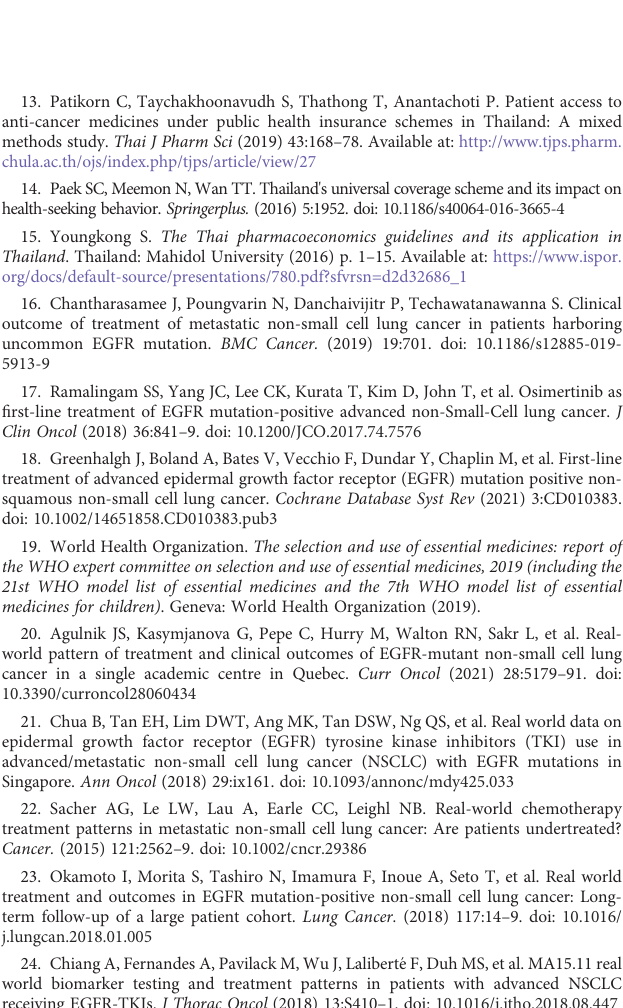
SUPPLEMENTARY FIGURE A Overall survivalby EGFR mutation subtype.mOS =medianoverall survival;HR= hazard ratio; CI = con fi dence interval. SUPPLEMENTARY FIGURE B Overall survival in patients with acquired T790M mutation with and without osimertinib treatment. mOS = median overall survival; HR = hazard ratio; CI = con fi dence